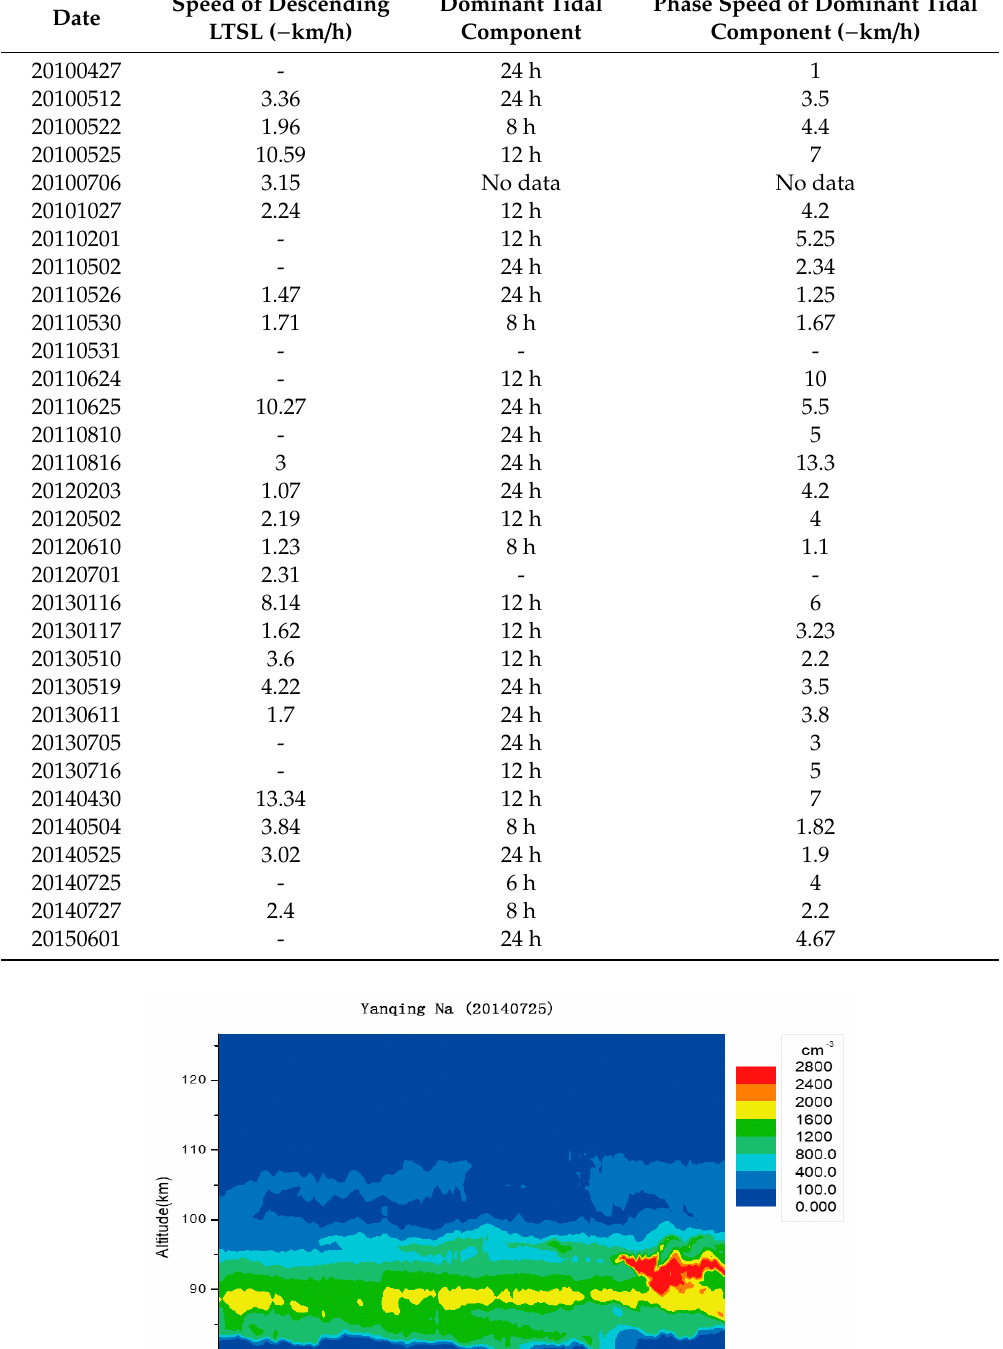
Table 3. The parameters of zonal wind.